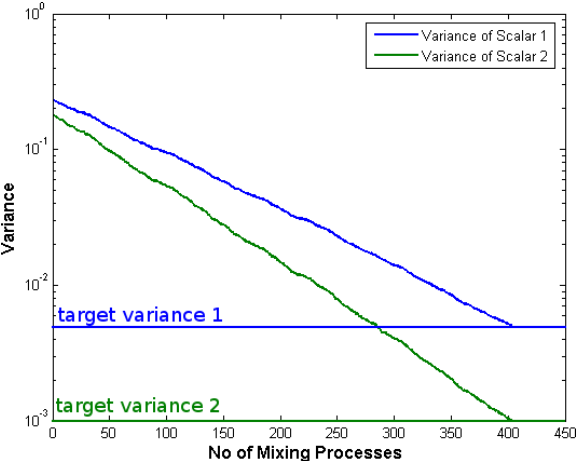
Fig. 3 Variance decay over mixing processes for the Modified Curl Model over a total of 400 mixing processes with 1600